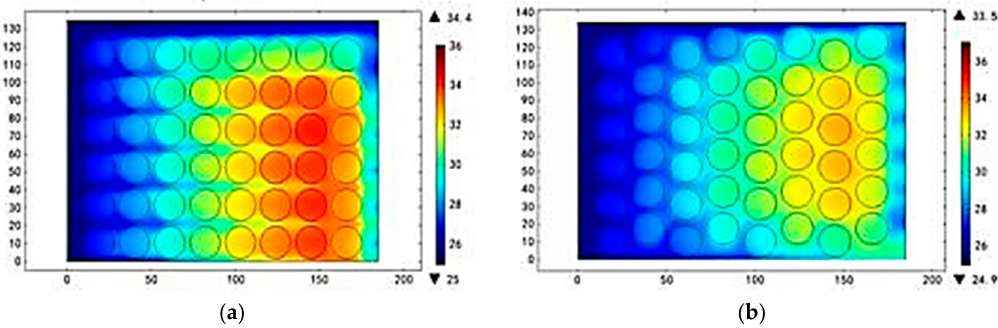
Figure 5. Battery temperature profiles with different battery arrangement at the rate of 1.0 m/s in ( a ) planar arrangement and ( b ) cross arrangement at 25 ◦ C and 1C discharging rate.